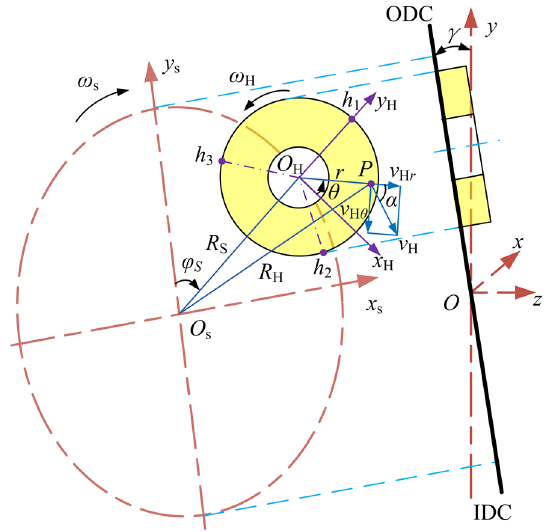
Figure 3. Kinetic analysis diagram of slipper.